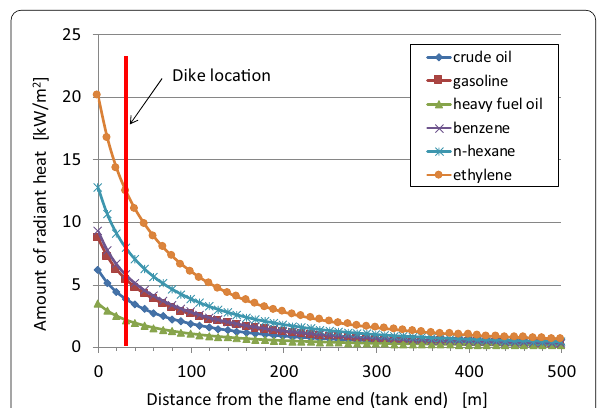
Fig. 5 Radiant heat intensity for distance from the flame end in an underground tank